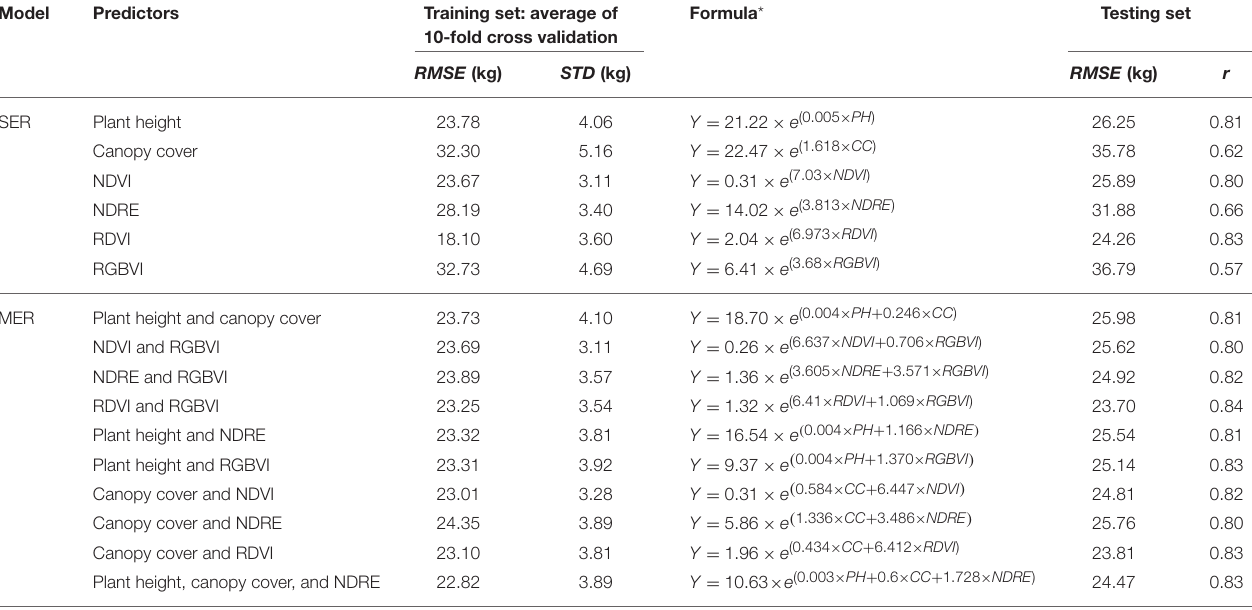
TABLE 4 | Fresh biomass estimation results in 10-fold cross validation as well as in the testing set, based on simple exponential regression (SER) and multiple exponential regression (MER) models. Model Predictors Training set: average of 10-fold cross validation